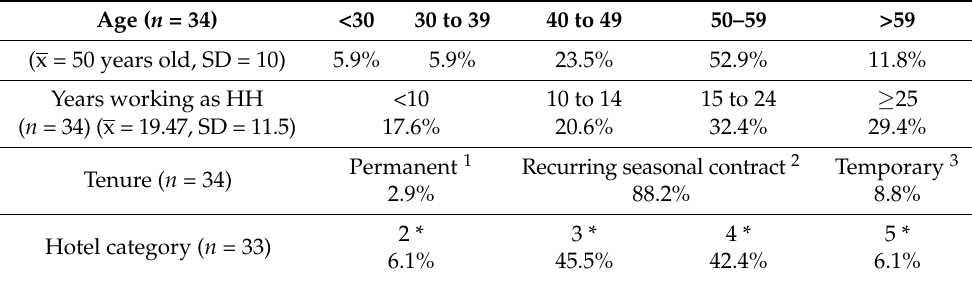
Table 1. Socio-demographic characteristics of participants in Focus Groups.